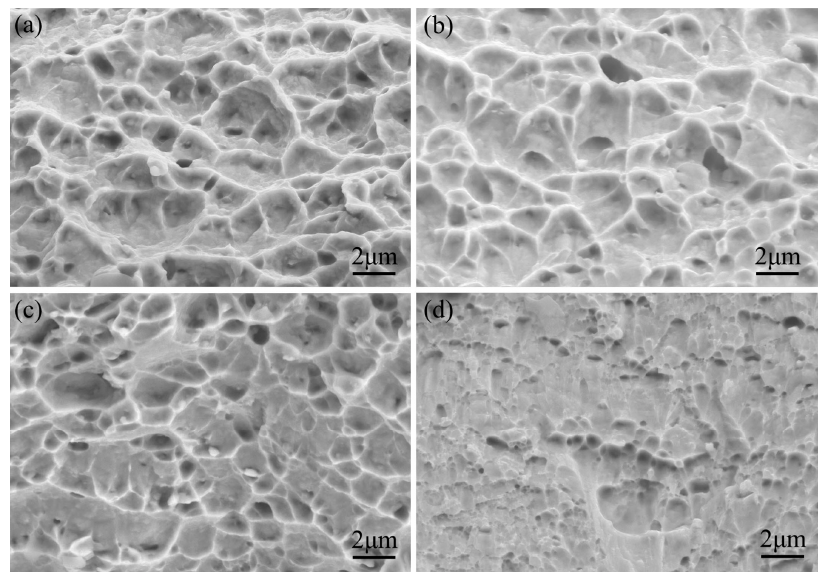
Figure 8. The fracture morphology after the tensile experiment of the Co40NiCrMo strips: ( a ) CSPB STACER; ( b – d ) winding and stabilization STACER under 480 °C + 4 h, 520 °C +4 h, and 560 °C +4 h, respectively.